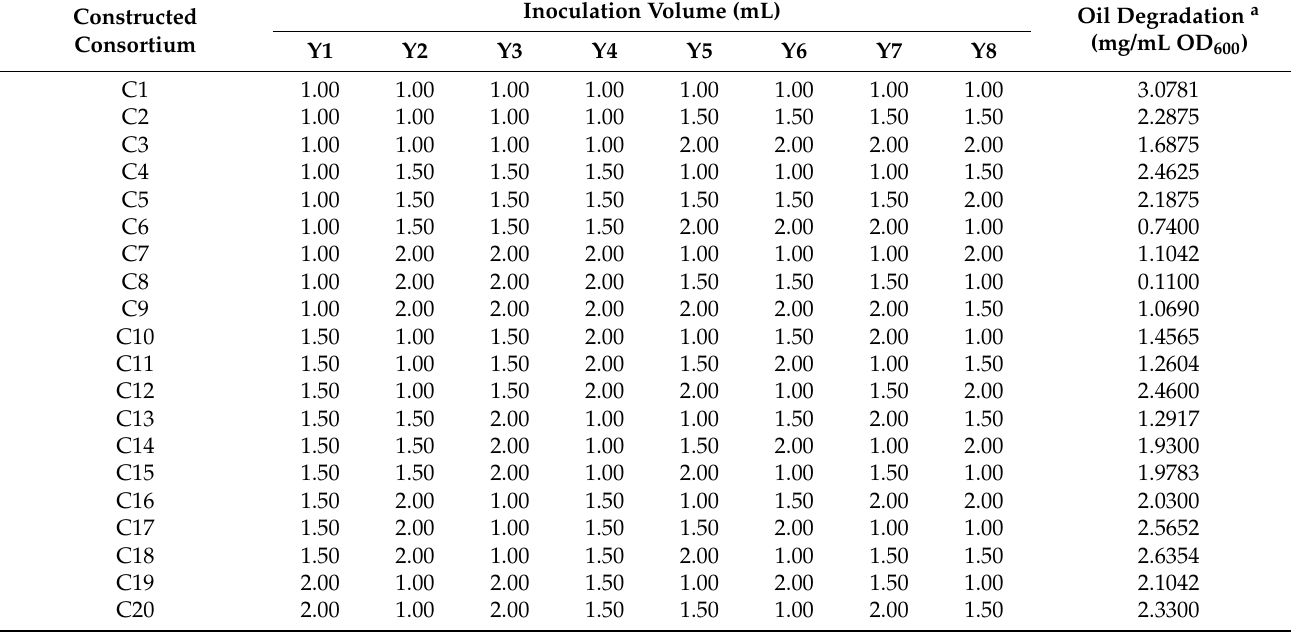
Table 2. Oil degradation amount by consortium constructed with orthogonal